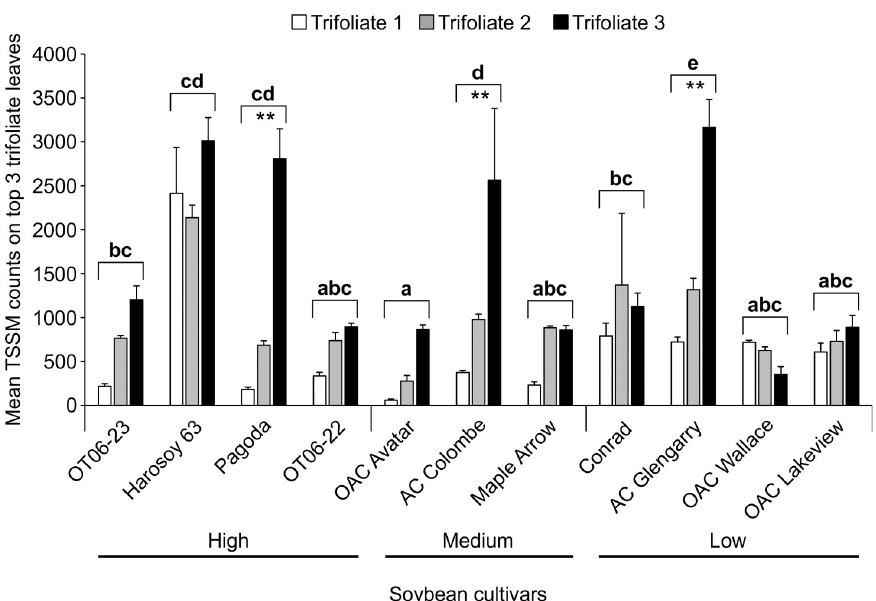
Fig 4. The performance of two-spotted spider mite on the top 3 trifoliate leaves of 11 soybean cultivars after 4 weeks. Data are mean ( ± S.E.) TSSM larvae, nymph, adult and egg counts. Bars with the same letters are not statistically different (2-way ANOVA, Tukey’s pairwise comparison, P > 0.05). Analysis of the 3 youngest trifoliate leaves indicated that 3 rd full leaves generally had higher ( �� = P < 0.05) TSSM counts than the 2 nd and top trifoliate for the most susceptible